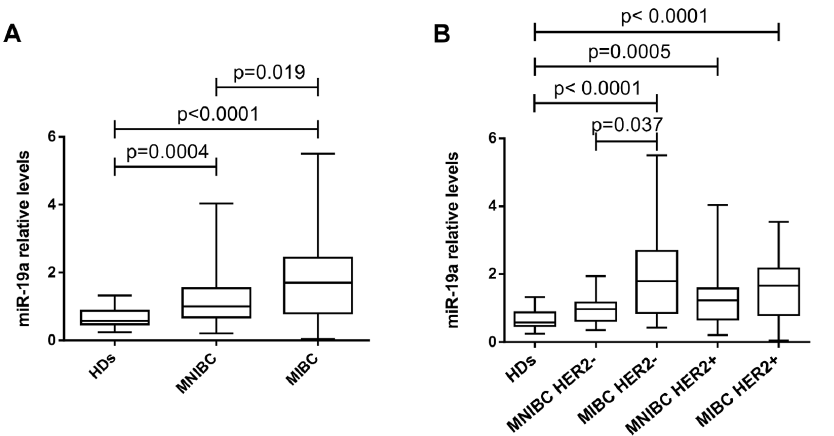
Figure 3. Serum miR-19a levels in patients with MIBC and MNIBC. The box plots show: a) relative serum miR-19a levels in patients with MNIBC and MIBC; and b) relative serum miR-19a levels in patients with MNIBC HER2 2 , MIBC HER2 2 , MNIBC HER2 + and MIBC HER2 + . Thirty HDs were included as controls. The differences in serum miR-19a levels were evaluated using the Mann-Whitney U test, and the p values are indicated above the plots.